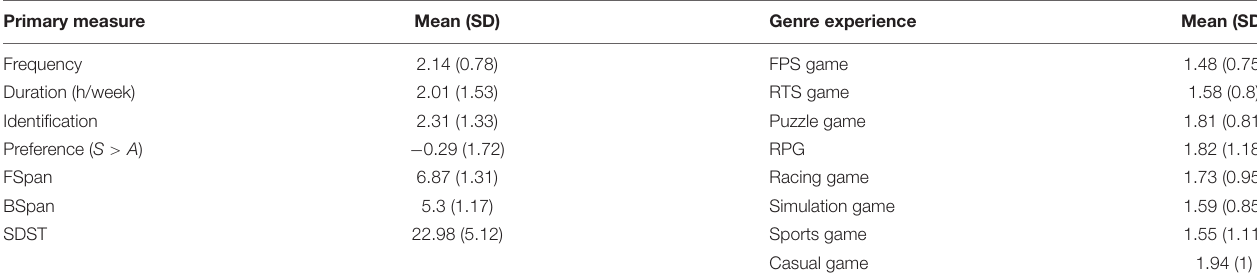
FIGURE 1 | Results of correlation analyses performed. Panel (A) depicts Pearson’s correlations between age and our variables of interest. Panel (B) depicts partial correlations between Action and Strategy LCs (learning composites) and our cognitive and game habit variables of interest, controlling for age and gender. Panel (C) depicts partial correlation between Action and Strategy LCs and participant reports of experience with eight specific genres of games, controlling for age and gender. Ident. = identification as a “gamer.” TABLE 1 | Means and standard deviations of behavioral and cognitive measures (left), and reported frequency of experience with specific game genres